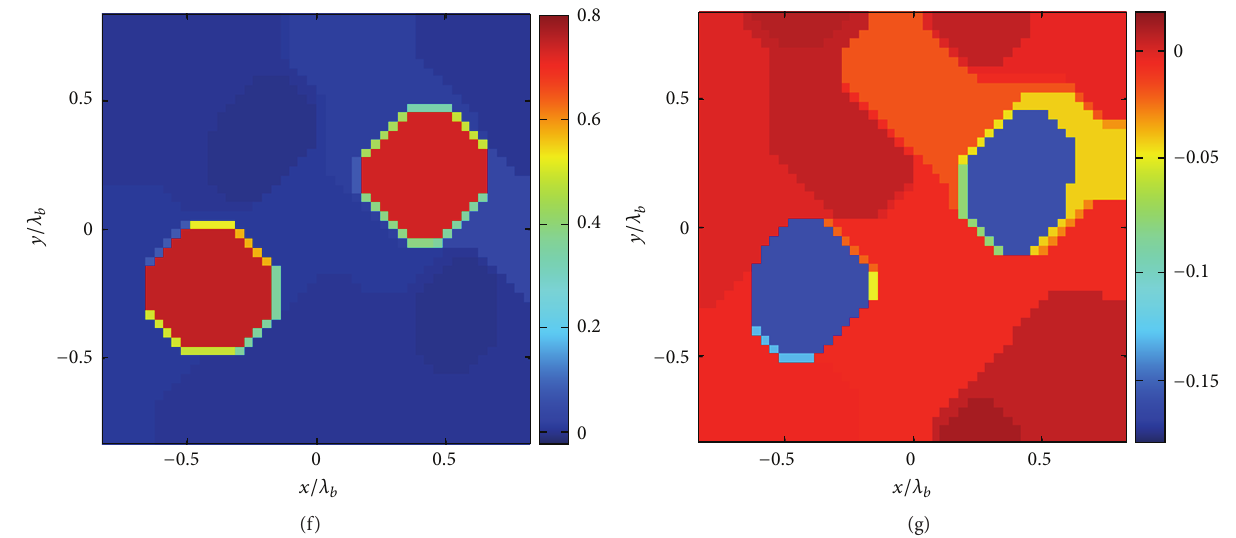
Figure 1: The two-cylinder example. (a) Real and (b) imaginary part of the contrast reference profile. (c) Normalized logarithmic LSM indicator with the selected pivot points superimposed as dots. The retrieved profile by means of the approach (4) ( 𝛿 = 0.2‖ b ‖ ℓ 10%): (d) real and (e) imaginary part. The retrieved profile by means of the approach (5) ( 𝛿 = 0.2‖ b ‖ ℓ